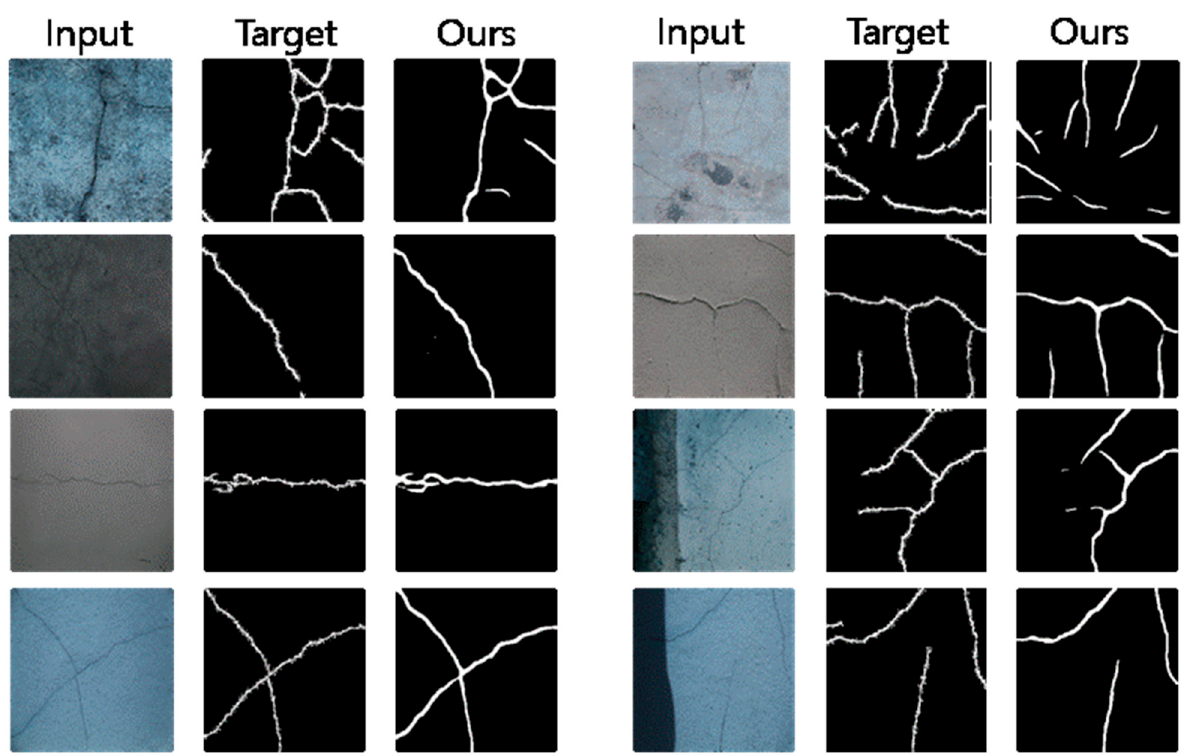
Figure 12. Images predicted by metamodel trained by the stacking ensemble technique.